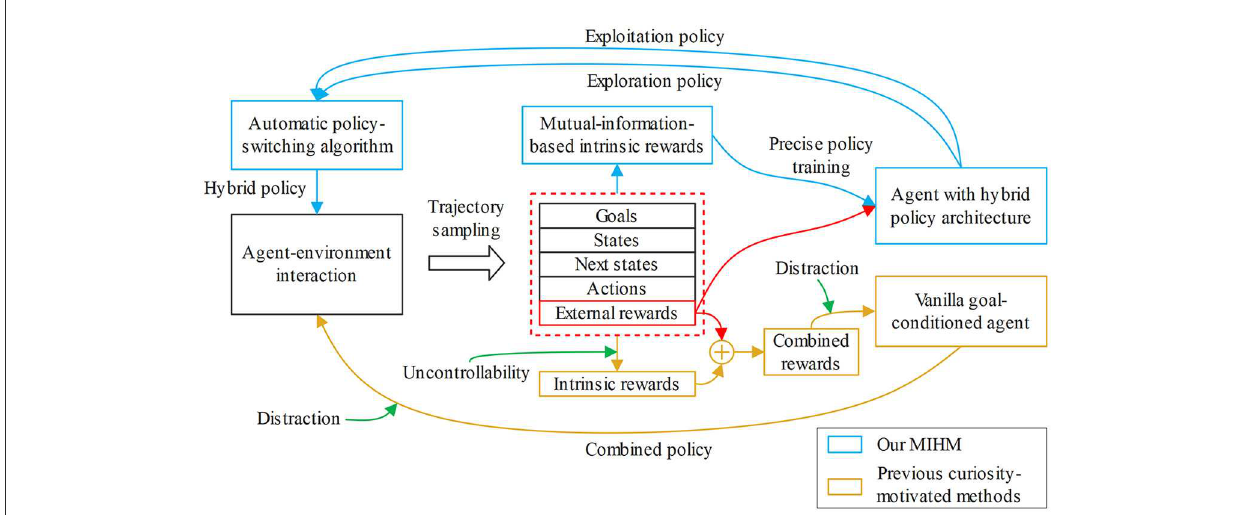
FIGURE1 Comparison between our MIHM and previous curiosity-motivated methods. The previous curiosity-motivated methods have two defects, uncontrollability and distraction, which deteriorate their performance in semantic-GCRL. Comparatively, our MIHM contributes two innovations, the decoupled-mutual-information-based intrinsic rewards and hybrid policy mechanism, which effectively solve these